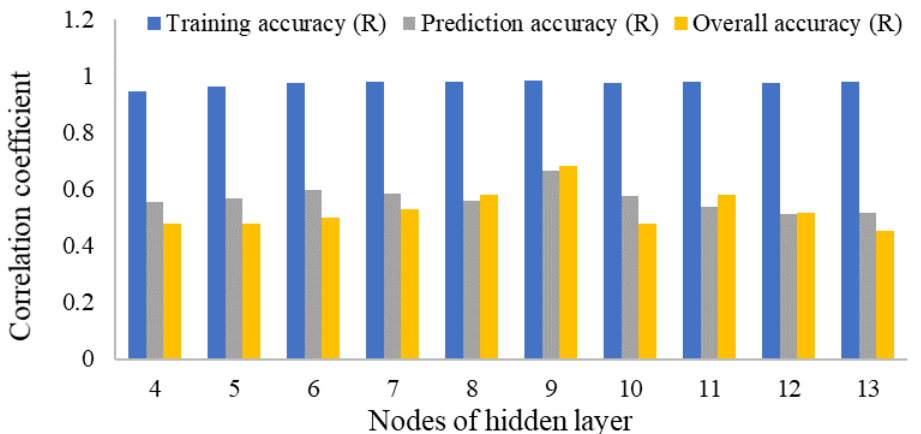
15 of 23 Table 2. Erf-BP neural network model using multiple remote-sensing data. Number of Nodes of the Hidden Layer